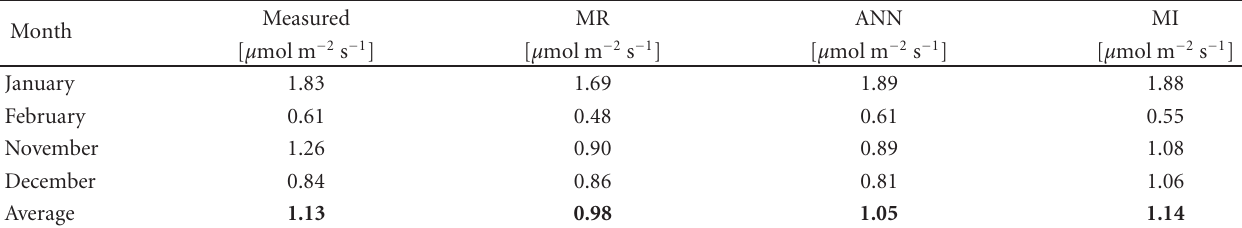
Table 2: Monthly averages of the measured CO 2 flux and of the CO 2 flux gap filled MR, ANN, MI for cold